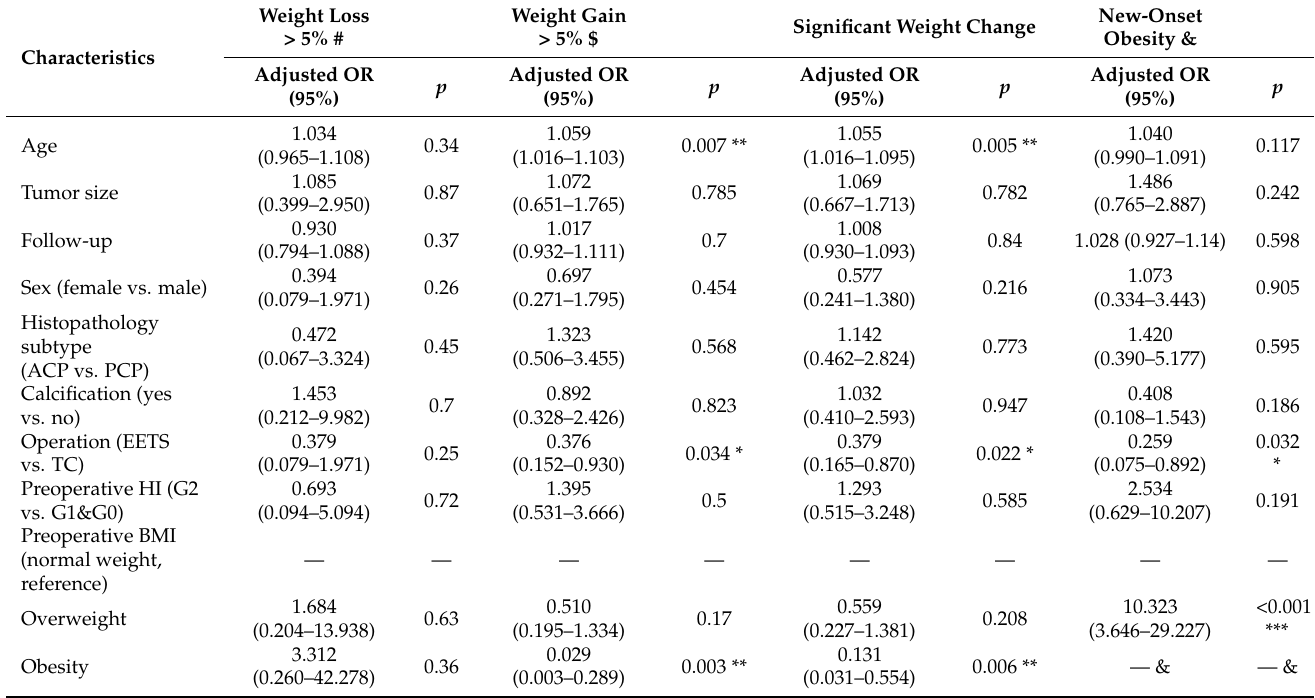
Table 5. Independent factors for weight loss > 5%, weight gain > 5%, significant weight change, and postoperative obesity. The multivariate logistic regression analysis showed that EETS was an independent protective factor for weight gain > 5%, significant weight change, and new-onset obesity. #, the patients with stable weight were regarded as control events; 55 patients with weight gain > 5% were excluded. $, the patients with stable weight were regarded as control events, and 10 patients with weight loss > 5% were excluded. &, new-onset obesity was defined as obesity that occurred in patients without preoperative obesity during the follow-up; 15 patients with preoperative obesity were excluded. —, not reported; *, p < 0.05; **, p < 0.01; ***, p <